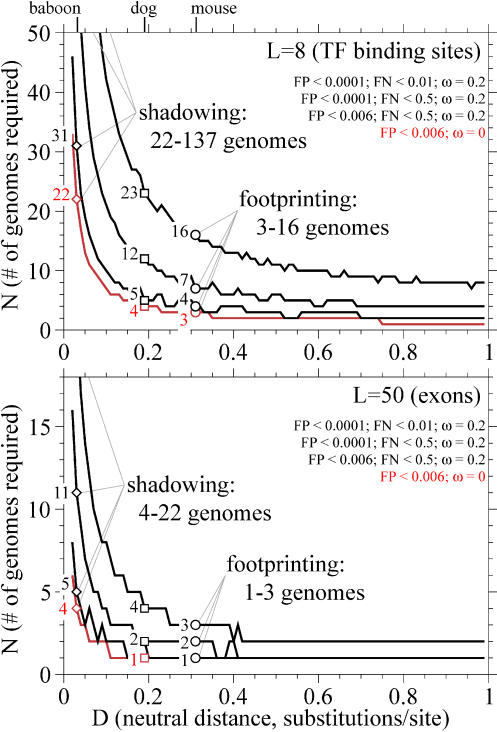
Number of Genomes Required for 8-nt or 50-nt ResolutionTop: identifying 8-nt conserved features (“transcription factor binding sites”; L = 8); bottom: identifying 50-nt conserved features (“exons”; L = 50). Parameter settings are indicated at top right, in same order as the plotted lines. The parameters are the same as those used in Figure 1.